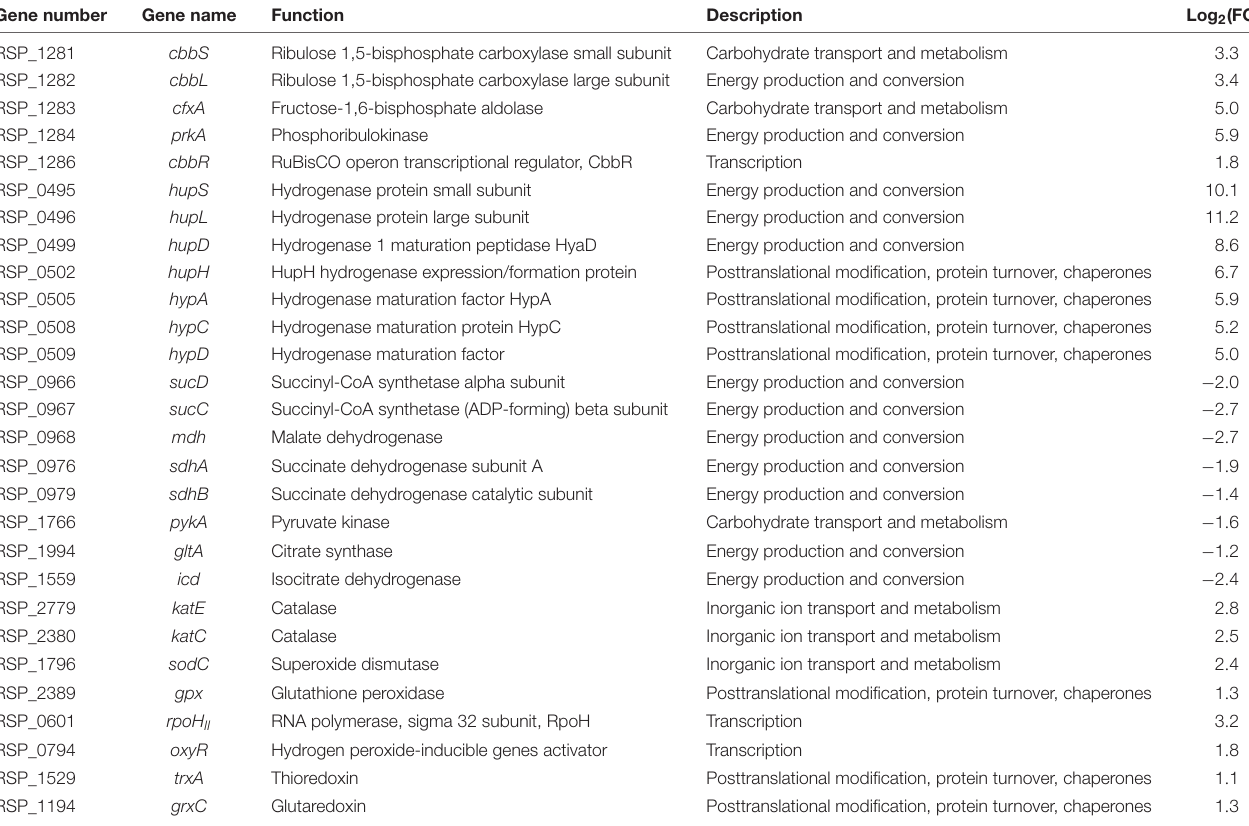
TABLE 1 | Comparison of transcript expression levels in autotrophic conditions vs. heterotrophic